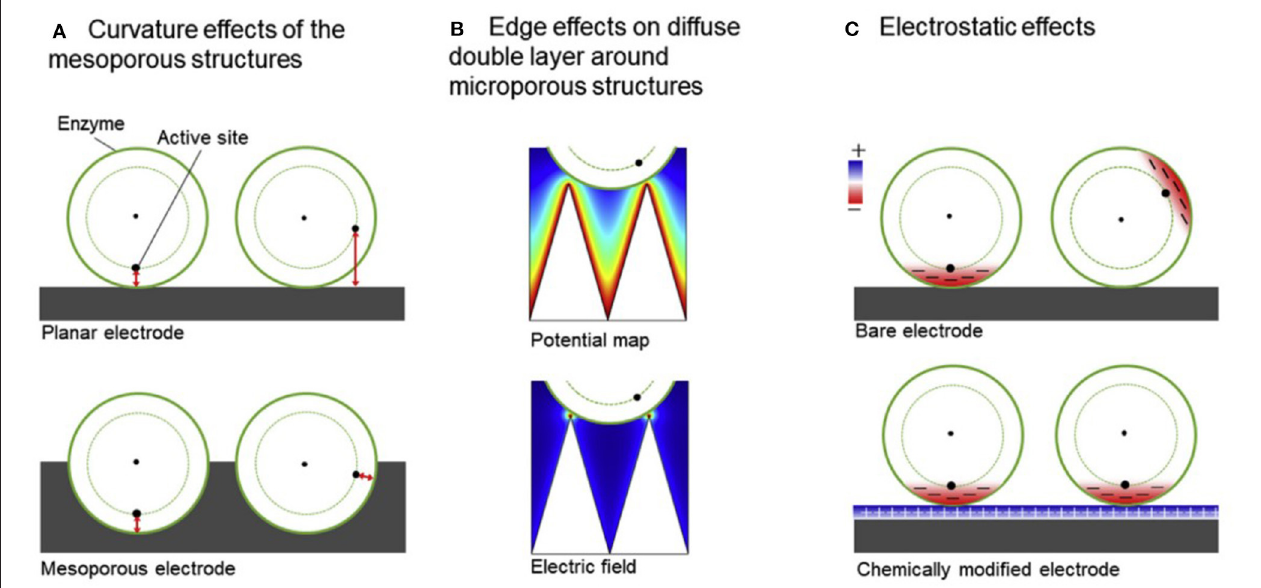
FIGURE 6 | Schematics showing (A) curvature effect (B) edge effect (C) electrostatic effect that are taken into account for meso- and microporous structures (Sakai et al., 2018 ).